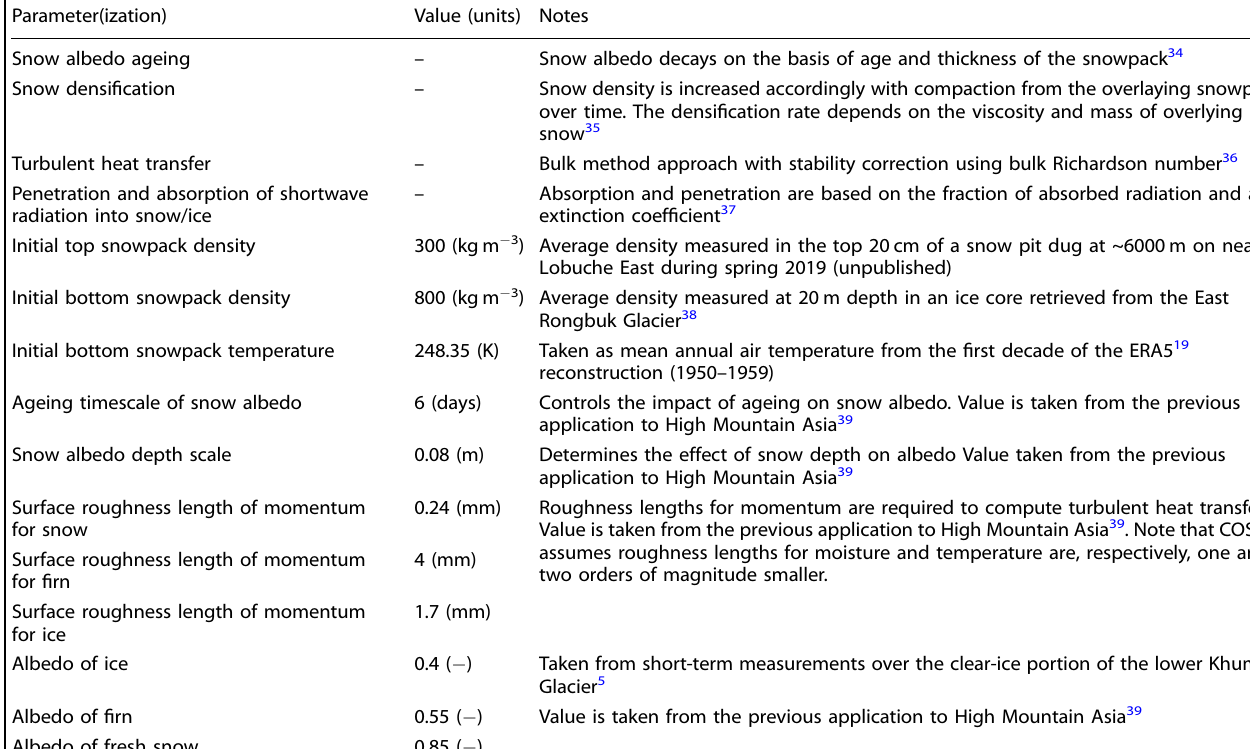
Table 2. Parameterizations and parameter values used in the COSIPY model runs.